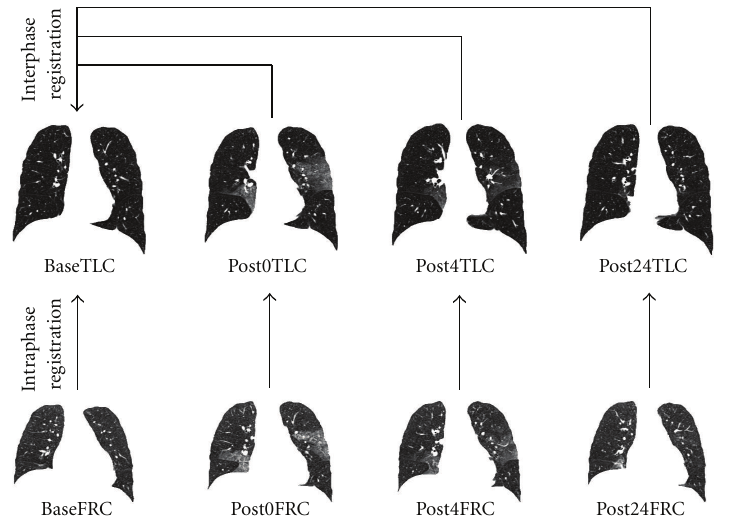
Figure 2: For each subject, intraphase registrations register the FRC image to the TLC image within a phase; interphase registrations register all TLC images in post-lavage phases to baseline